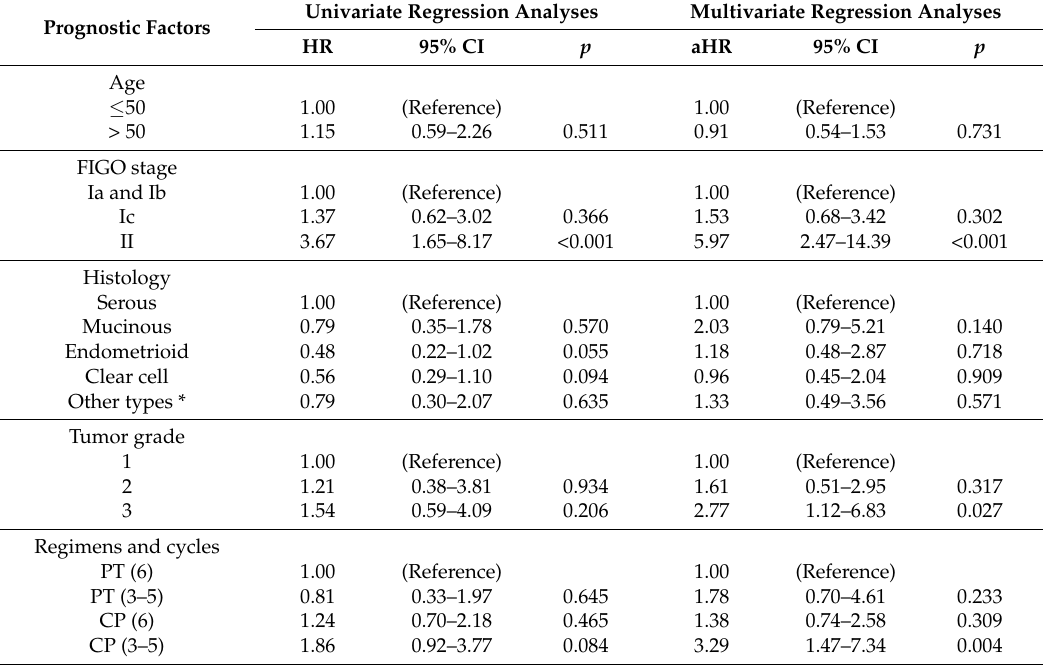
Table 2. Prognostic factors for overall survival of 437 early stage ovarian cancer women by univariate and multivariate Cox regression